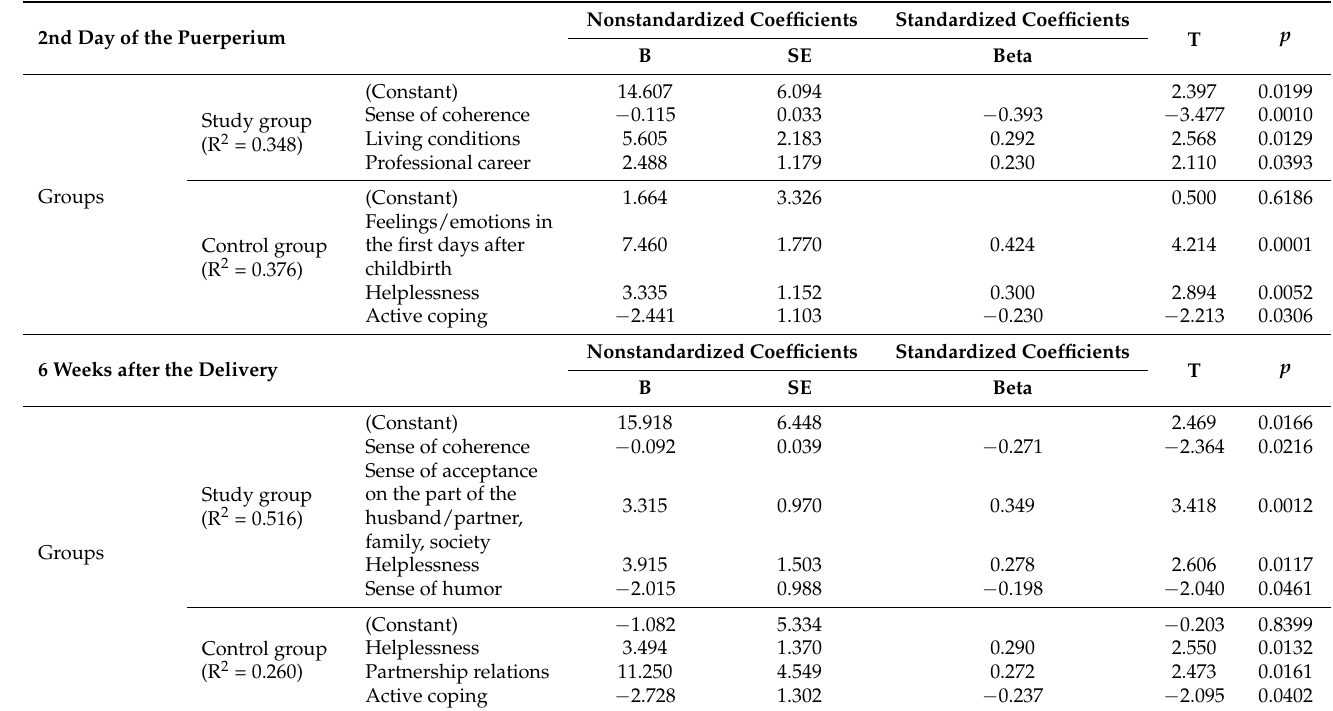
Table 3. Severity of depression symptoms among women participating and not participating in antenatal classes (linear regression using the stepwise method